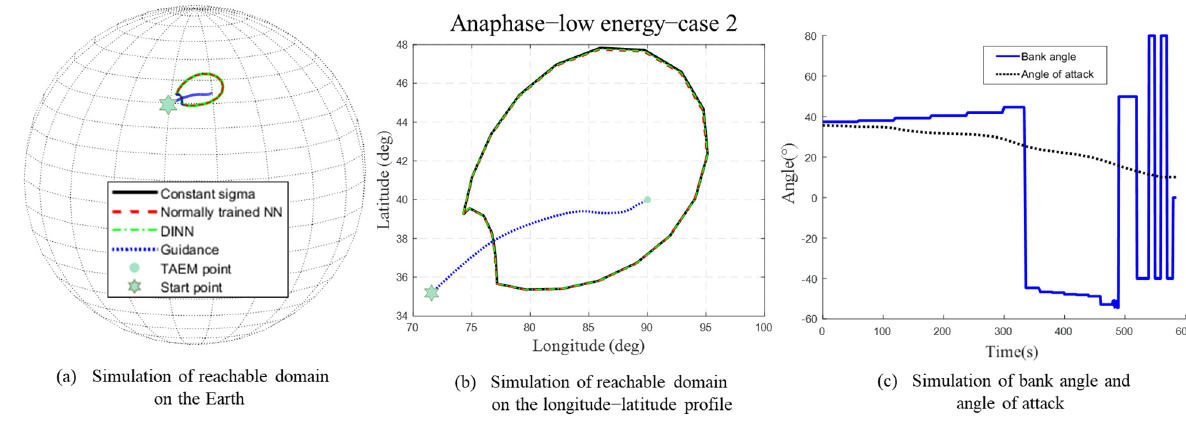
Figure 11. Simulation of low energy Case 2.